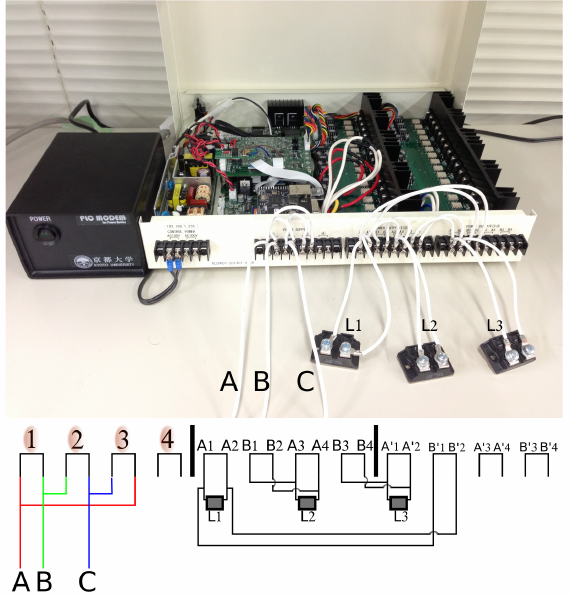
Figure 4. Experimental prototype power router and connection setup of input and output phases. This power router can be fed with up to four input sources and has eight